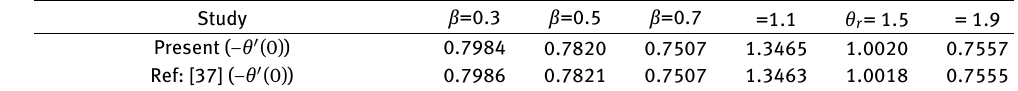
Table 2: Validation of − θ (cid:48) (0) with Reddy et al. [37] by taking Ek = 0, m = 1, H 1 = H 2 = 0 .